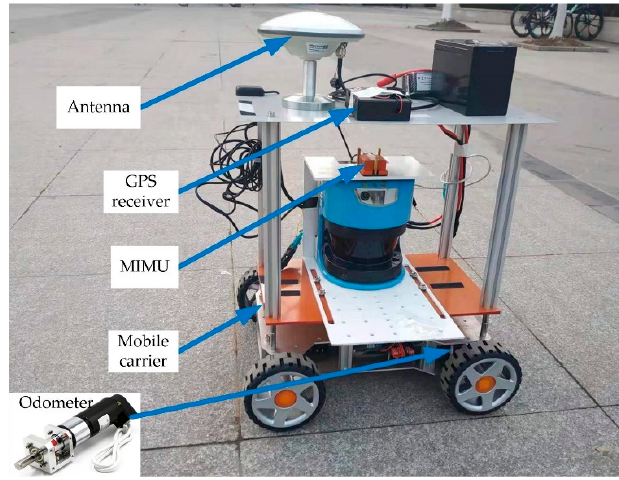
Figure 5. Experiment mobile carrier and the equipment. Table 1. Specifications of the MIMU and initial errors.